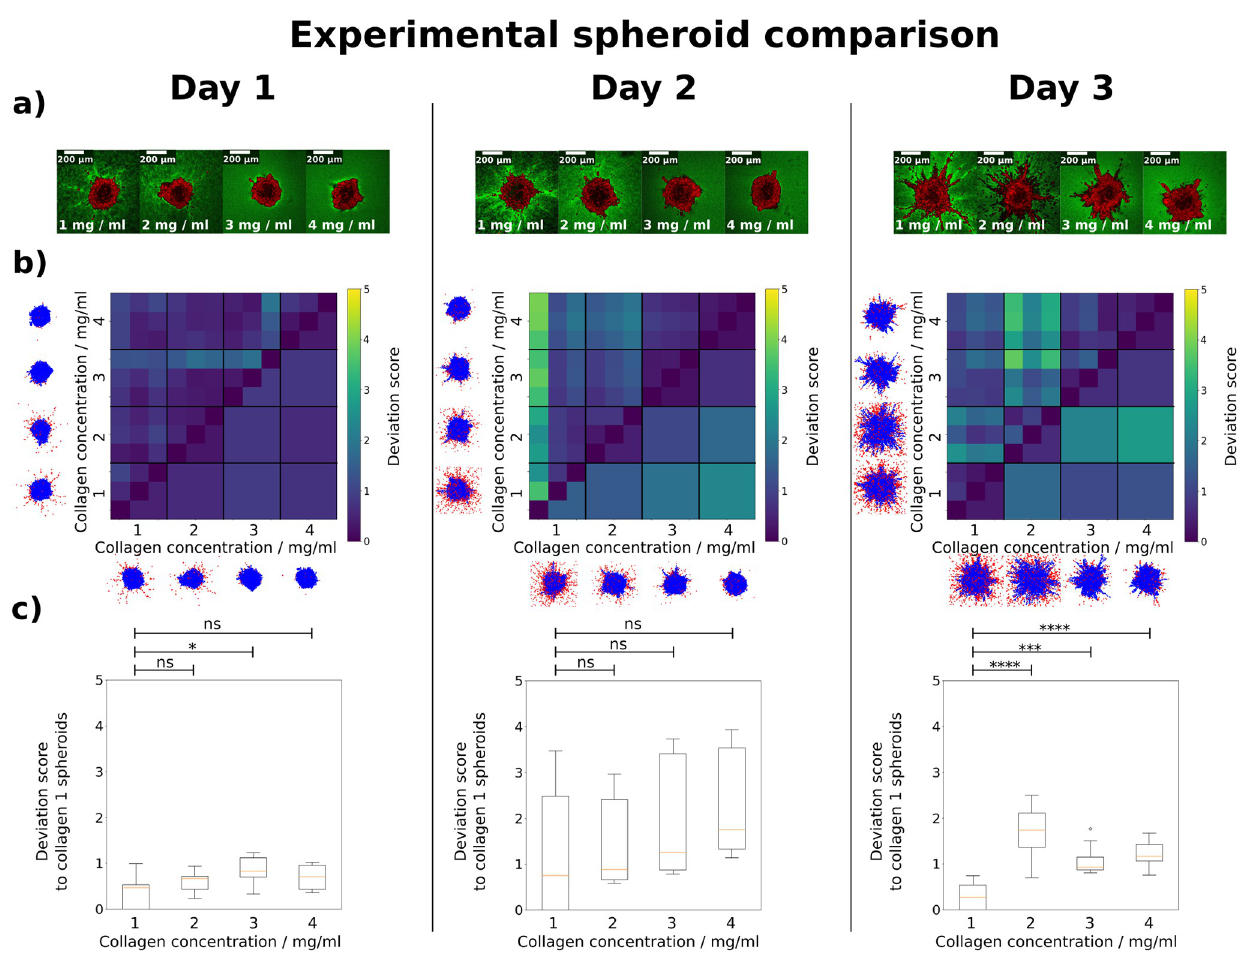
Fig 7. Deviation score comparison for in vitro MDA-MB-231 spheroids cultured in four collagen concentrations c (data provided by Kang et al [13]). a) 2D cross-sections of 3D multiphoton microscopy image stacks depicting one replicate of each collagen concentration [13]. Spheroids were imaged at one, two or three days after embedding in collagen, and were then fixed and imaged (see Section 4.3). b) Deviation score comparison between all spheroid samples. For each day, the deviation scores for three replicates of each collagen concentration are shown on the upper triangle, and the average deviation score for each collagen concentration is shown on the lower triangle. A top-down view of the spheroid point cloud for a representative replicate of each collagen concentration is shown next to each heatmap (see S2 Fig for all replicates). Blue cells are classified as non-gaslike, and red cells are classified as gaslike. Due to matching initial conditions, we observe low deviation scores between spheroids grown for one day. These differences increase at day 2, where we observe an approximately linear increase of the average deviation score from c = 1 mg/ml to c = 4 mg/ml. Finally, at day 3, we observe the lowest deviation between c = 3 mg/ml and c = 4 mg/ml. This underlines the findings by Kang et al., who observed a transition in invasion behavior between 2 mg/ ml and 3 mg/ml. c) Deviation score box plots from spheroids grown for one, two and three days respectively. The box plots for each day show the deviation score values between c = 1 mg/ml and each other concentration. These values correspond to those used for the lowest rows in b). We observe that for spheroids grown for one and two days, the deviation score values of c = 1 mg/ml compared with itself are similar to the deviation score values of c = 1 mg/ ml compared with the other concentrations. The differences are nonsignificant and therefore not sufficient to clearly distinguish between the concentrations. This changes at day three, where each concentration shows a higher deviation score to c = 1 mg/ml than c = 1 mg/ml compared with itself. Significance was determined using Welch’s